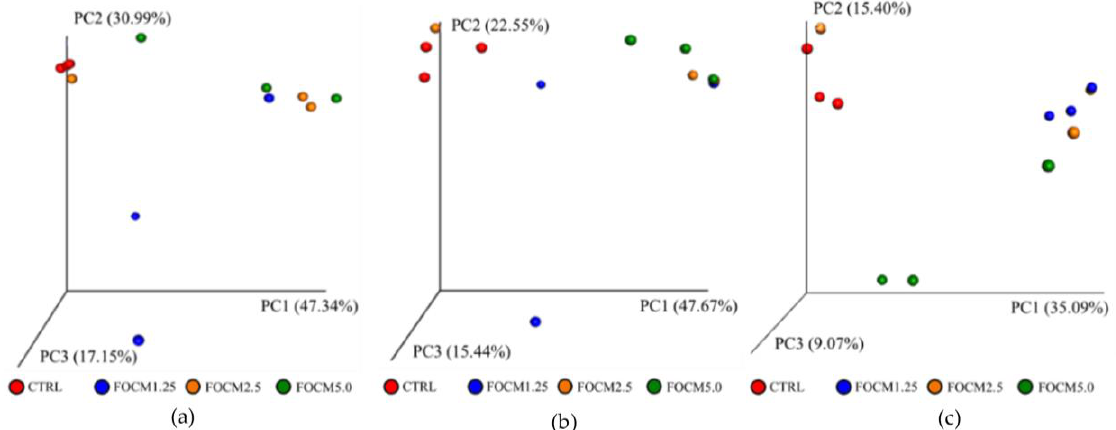
Figure 6. Comparison of the bacteria communities of the ileal contents by advanced analysis. Princi-